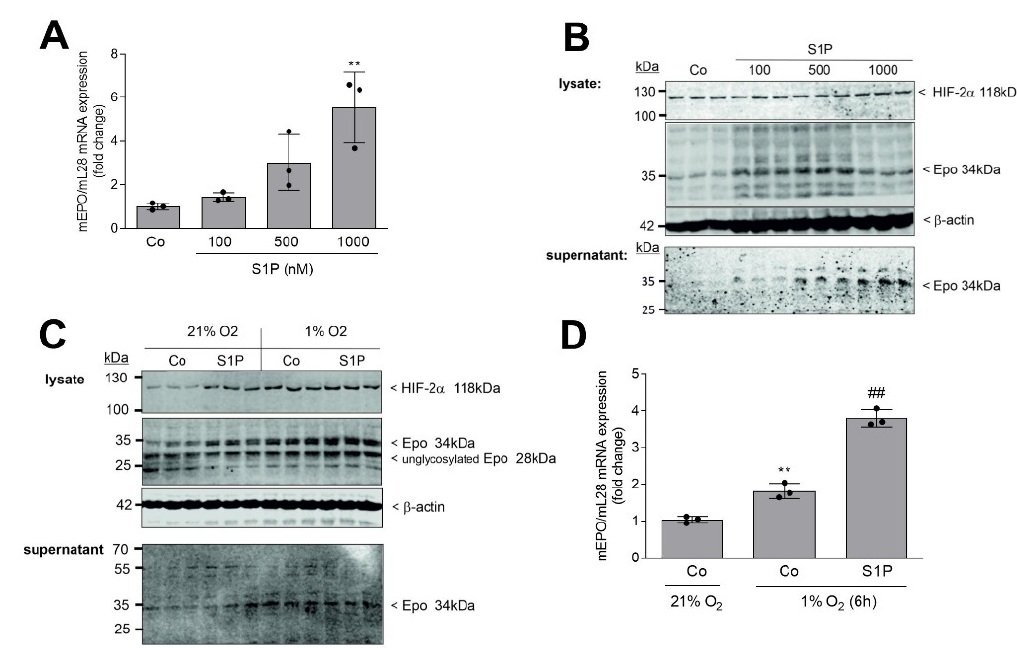
Figure 1. Effect of S1P and hypoxia on Epo mRNA and protein expression in F3-5 cells. ( A , B ): Confluent F3-5 cells were incubated for 16 h with serum-free DMEM prior to stimulation for 6 h with the indicated concentrations of S1P. ( C , D ): Cells were incubated for 6 h under normoxia (21% O 2 ) or hypoxia (1% O 2 ) in the absence (Co) or presence of 500 nM S1P. RNA extracts ( A , D ) were prepared and taken for quantitative PCR analysis using primers for mEpo and mL-28 (for normalization). ∆∆ Ct values were calculated and the results show the fold change compared with the untreated control and are means ± S.D. ( n = 3), ** p < 0.01 considered statistically significant when compared with the control samples; ## p < 0.01 compared with the 1% O 2 -Co samples. Protein extracts ( B , C ) were prepared and taken for protein separation by SDS-PAGE; transferred to nitrocellulose membranes; and subjected to Western blot analyses using antibodies against mouse Epo, HIF-2 α , and β -actin. Bands in B and C, corresponding to Epo, HIF-2 α , and β -actin, were evaluated by Image Studio Lite software, and results are depicted in Supplementary Figure